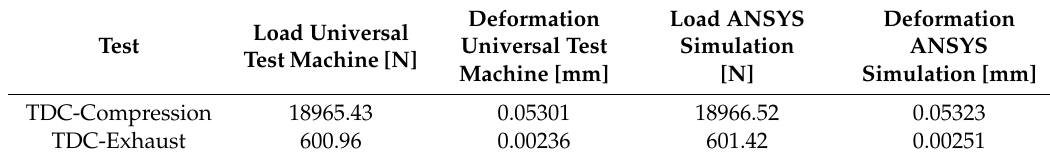
Table 4. Comparative experimental results—ANSYS